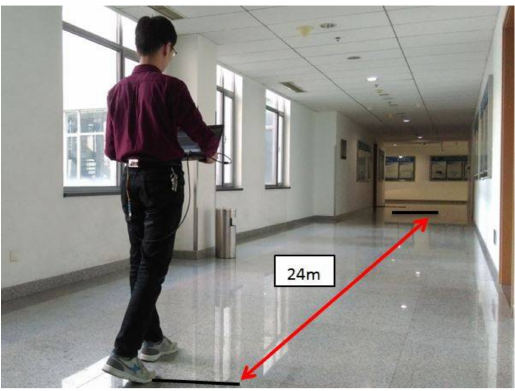
Figure 7. The parameter calibration